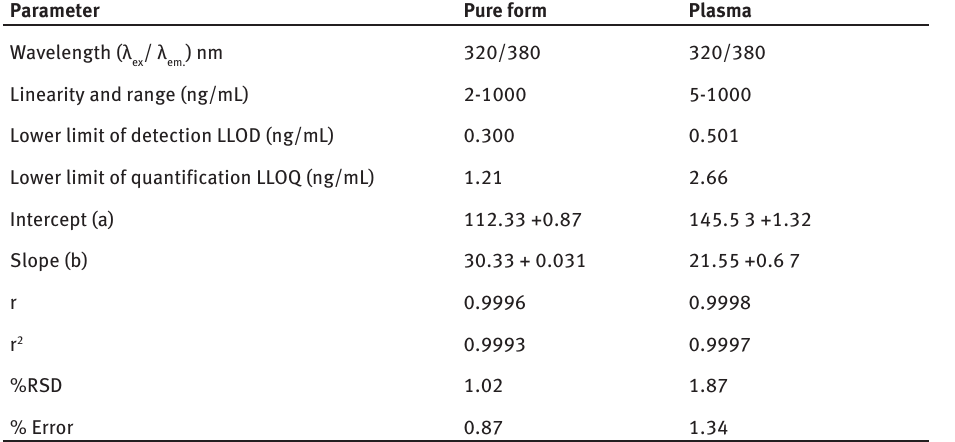
Table 2: Analytical performance data for the spectrofluorimetric quantification of DCV in pure form and spiked plasma. Parameter Pure